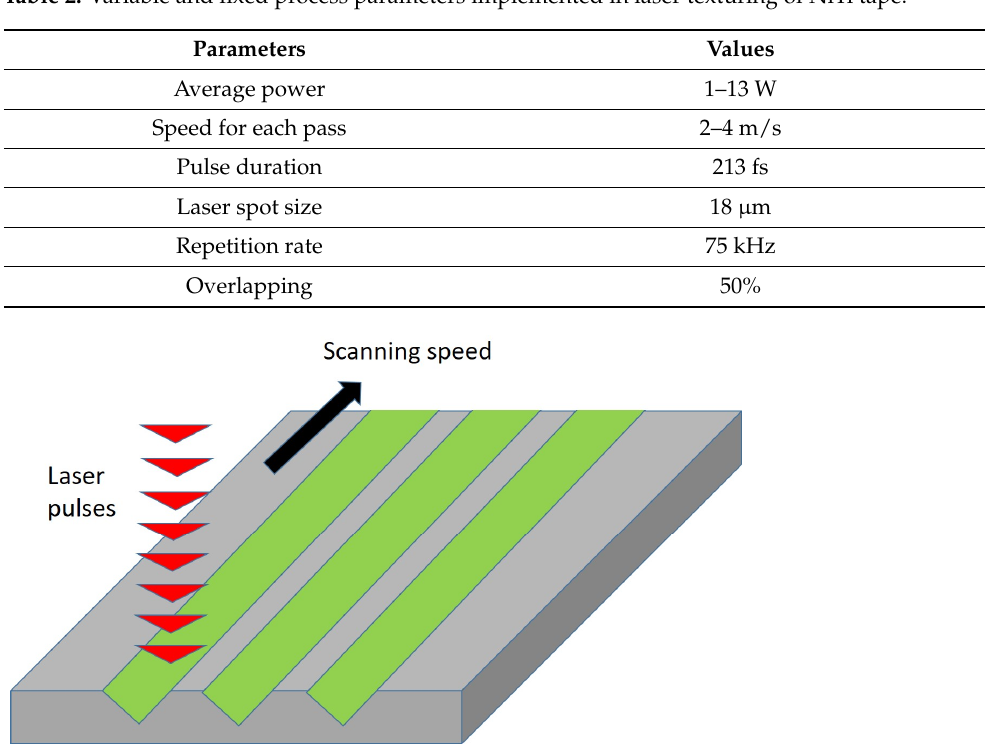
Table 1. Main characteristics of the femtosecond laser source used in the texturing experiments.